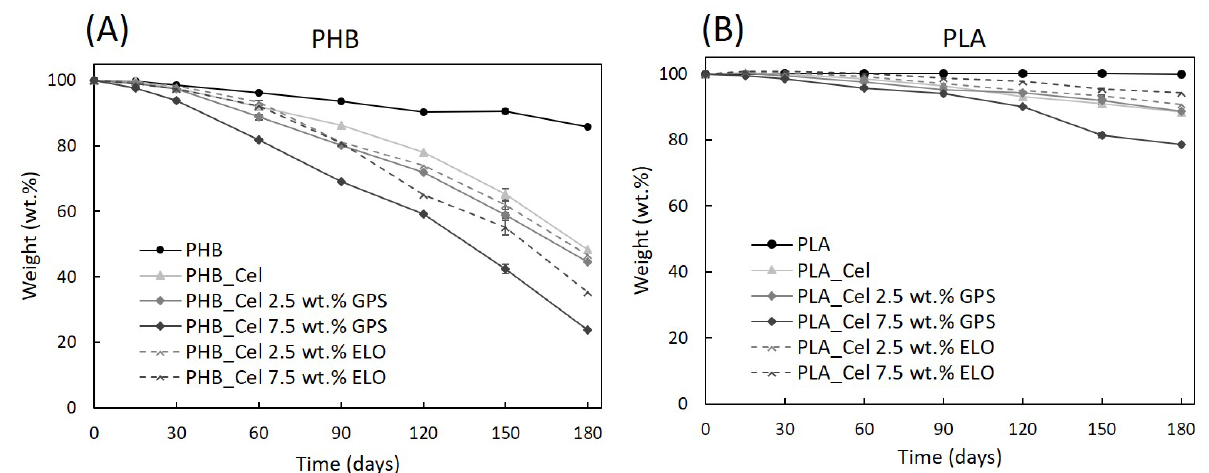
Figure 8. Weight loss as a function of time for the PHB- ( A ) and PLA-based composites ( B ) without additives and with different loads of GPS and ELO additives. The standard deviations (not shown) are under 7.6% for PHB-based materials and under 3.9% for PLA-based materials, and the lines are for visual guidance only.